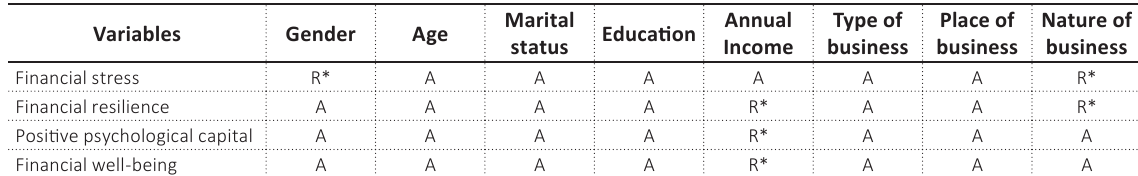
Source: Analysis of survey